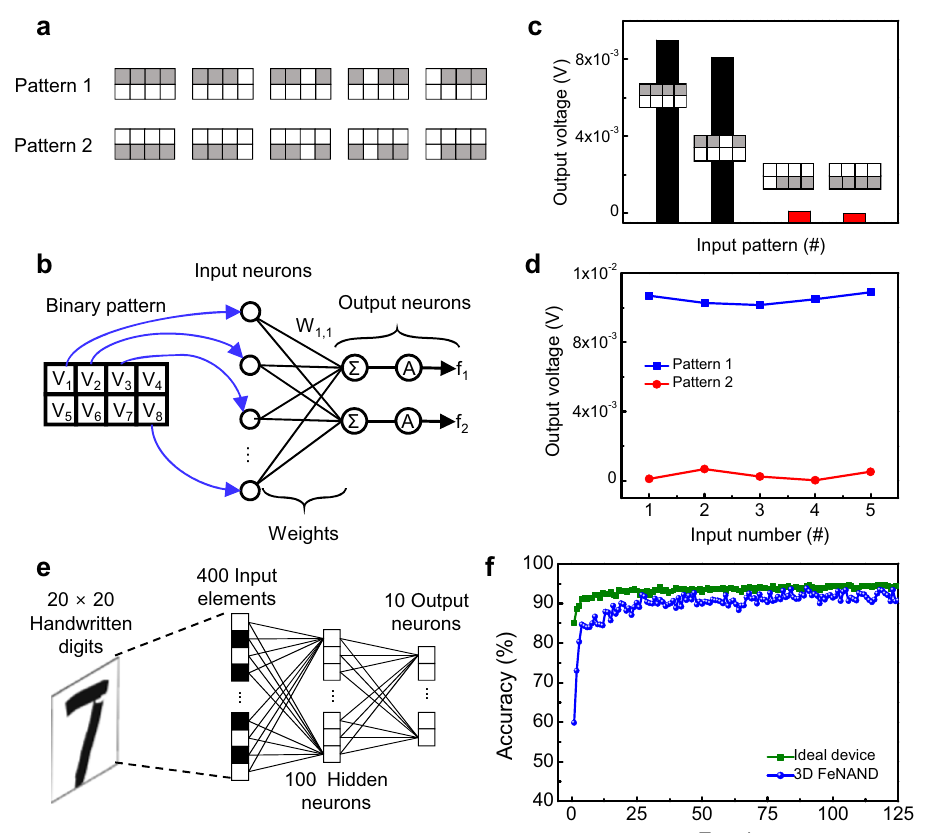
Fig. 4 | Image classi fi cation using 3D FeNAND array. a Example of training and test pattern set. Two-class image set which was comprised of a total of 20 training images of black and white patterns representing line patterns with a size of 4×2 pixels was used as a training and test image set. b Schematic illustration of binary image classi fi cation using 3D FeNAND. The value of each pixel in the input image wasconvertedintovoltagesof0(black)or1V(white)andassignedtoeachBLinthe 3D FeNAND array. The output I SL was measured and used as the input for neurons (op-amp). c Neuron output voltageswith different input patterns. The 3DFeNAND only showed a high output voltage when the black line was positioned over the